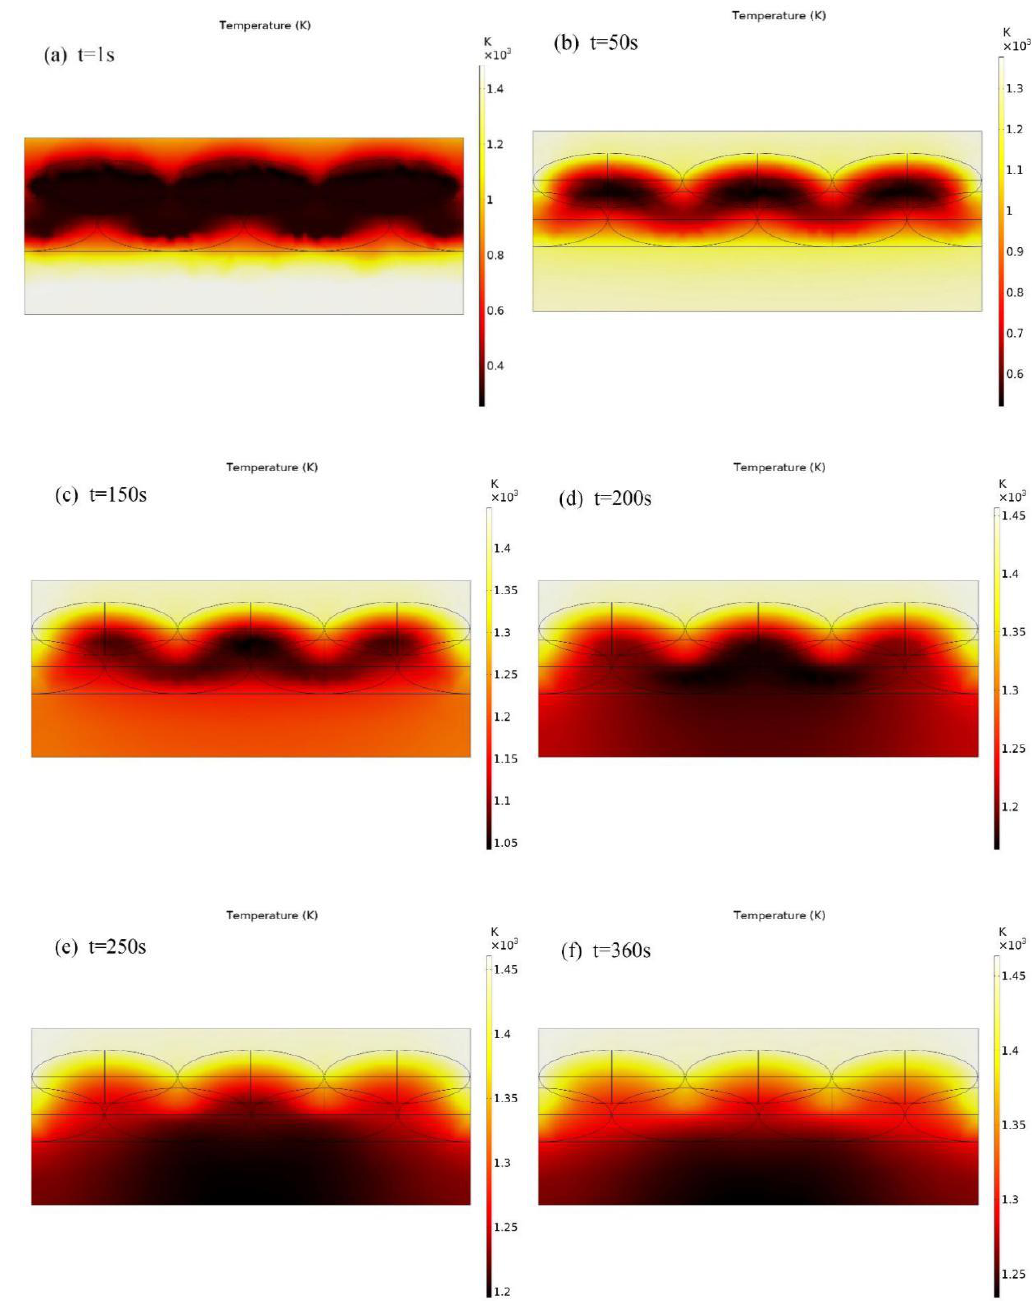
Figure 7 . Temperature gradient variation in the pellet bed middle section at different reduction